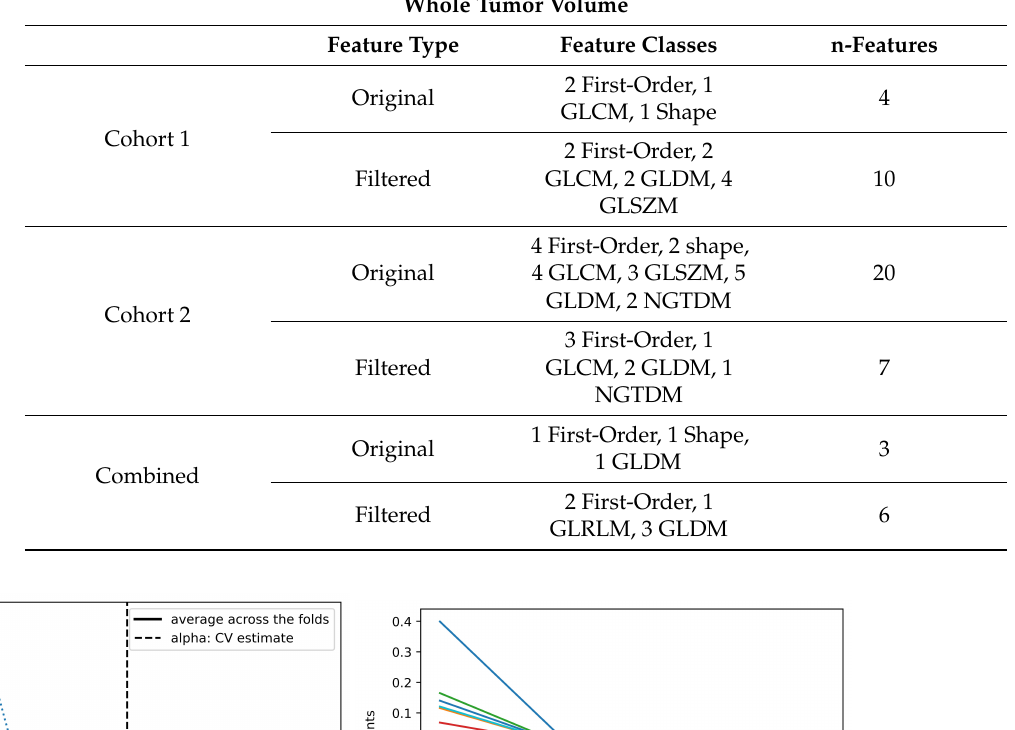
Table 6. Representation of robust features selected for Whole Tumor Volume.